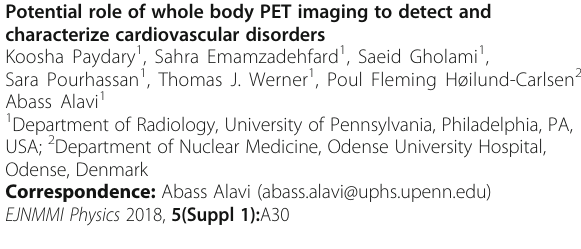
Table 1 (abstract A30). The average SUVmax, average SUVmean and GCS of each vascular segment of thoracic aorta in our total sample including 124 subjects, and the two subgroups of healthy subjects and patients with high risk of atherosclerosis. The P-value column represents